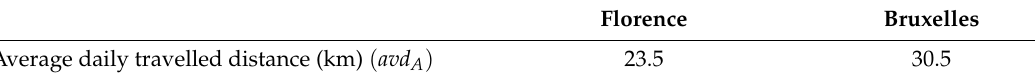
Table 11. Forecast average daily travelled distance by a passenger car over the analyzed